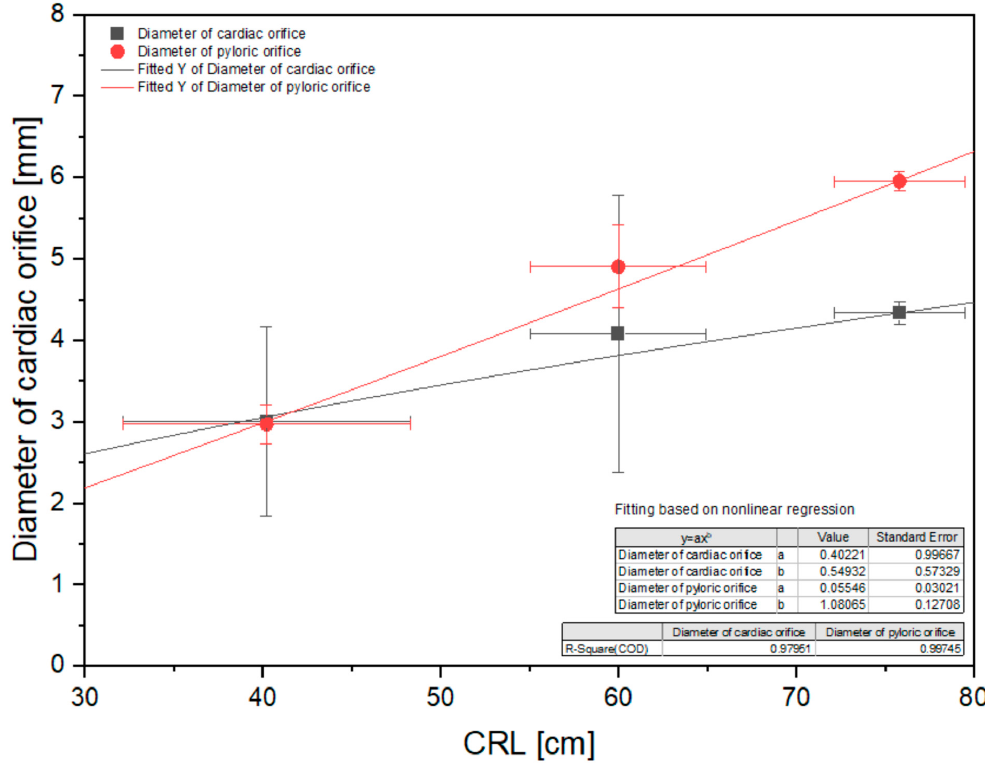
Figure 11. Nonlinear regression of the stomach morphometric values (diameter of the cardiac orifice and pyloric orifice). CRL—crown–rump length. The statistical analysis of the measurements revealed a nonlinear correlation of all values with CRL in all age groups. This allowed us to compare the allometric growth of the mentioned parameters with the isometric character of the CRL growth in the fetal pe- riod. The most intense positive allometric growth was observed for the length of the greater curvature, and for the other parameters (stomach length, width, thickness, and length of the lesser curvature) the positive allometric growth was weaker. In all cases, the values of the measured parameters increased as the pregnancy (the fetal period) pro- gressed (Figure 9). The growth rate of the distance from the cardiac orifice to the stomach fundus (depth of the blind ventricular sac) showed a slightly positive allometric character. More evident positive allometric growth was visible for the distance from the cardiac orifice to the greater curvature (width of the gastric wall along the visceral surface). Finally, the growth rate of opposite gastric wall width (distance from the cardiac orifice to the greater curva- ture and the parietal surface) can be described as strongly positive allometric in the first age group, gradually decreasing in the second age group, and strongly negative allometric in the third age group, as defined by the polynomial curve visible in Figure 10. The diameter of the cardiac orifice showed a slightly negative allometric growth, and the diameter of the pyloric orifice can be characterized as growing in a slightly negative allometric way (Figure 11).